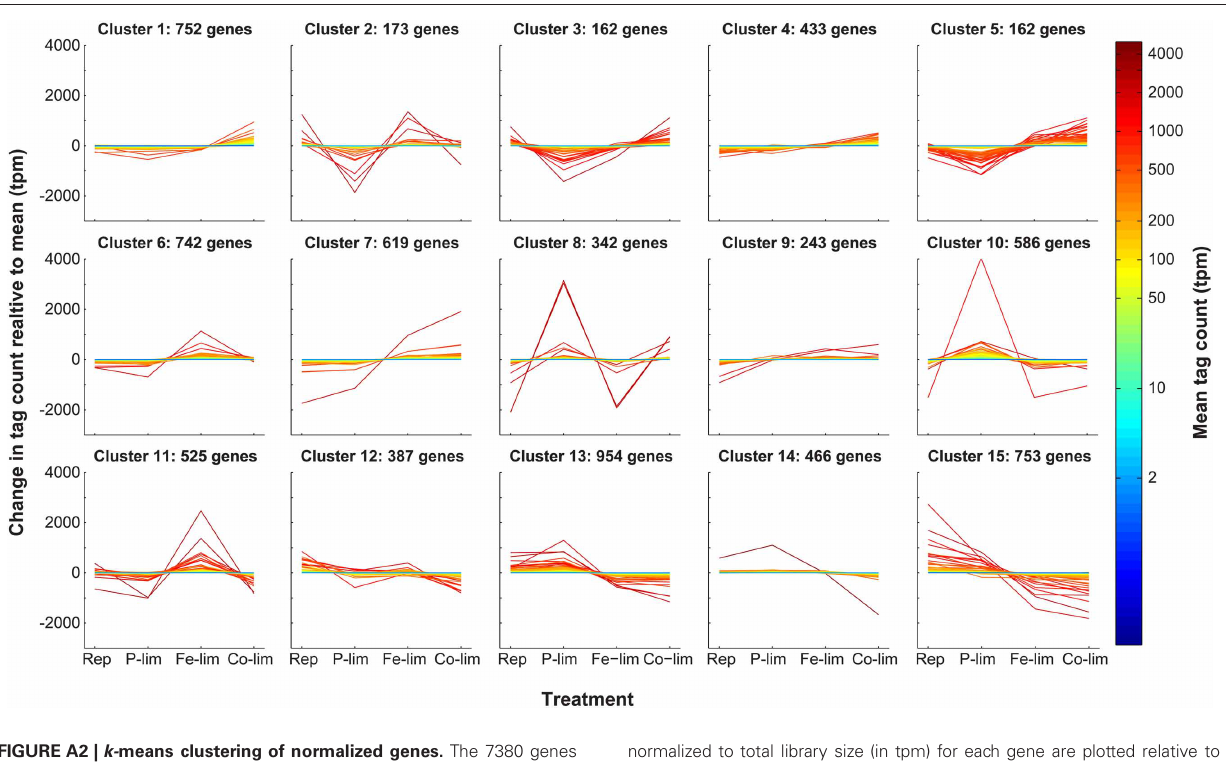
Frontiers in Microbiology | Aquatic Microbiology